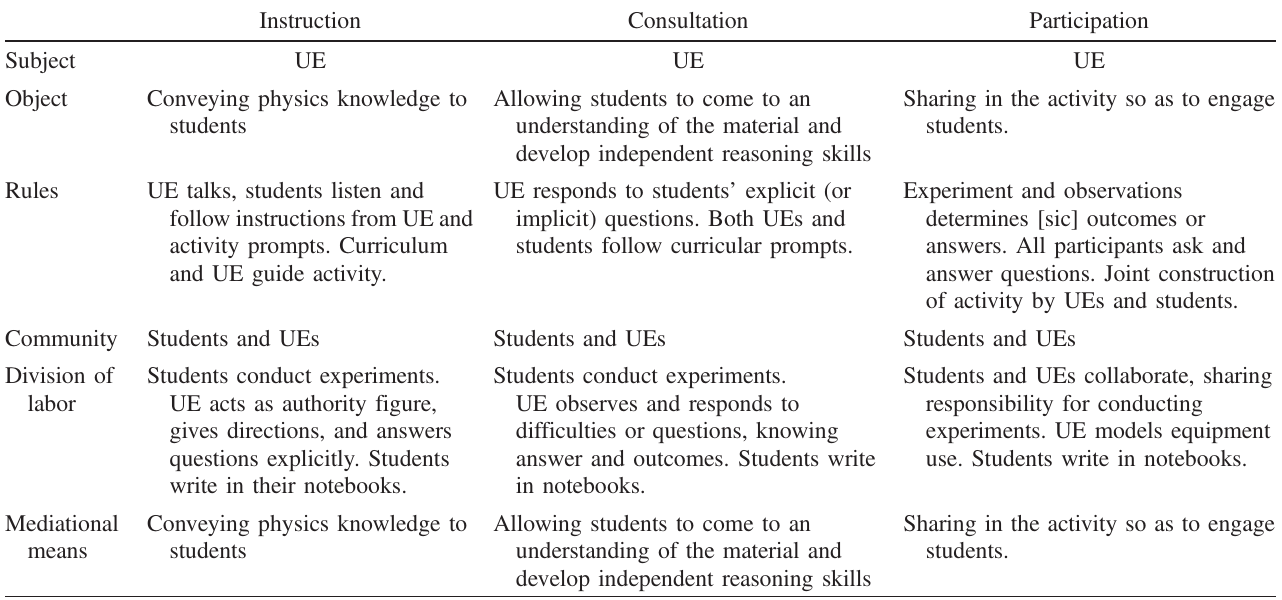
TABLE I. Comparison of CHATelements of the three pedagogical modes, as articulated in Ref. [12]. In the 2016 model, each mode is defined categorically and with mutual exclusion by its associated CHAT